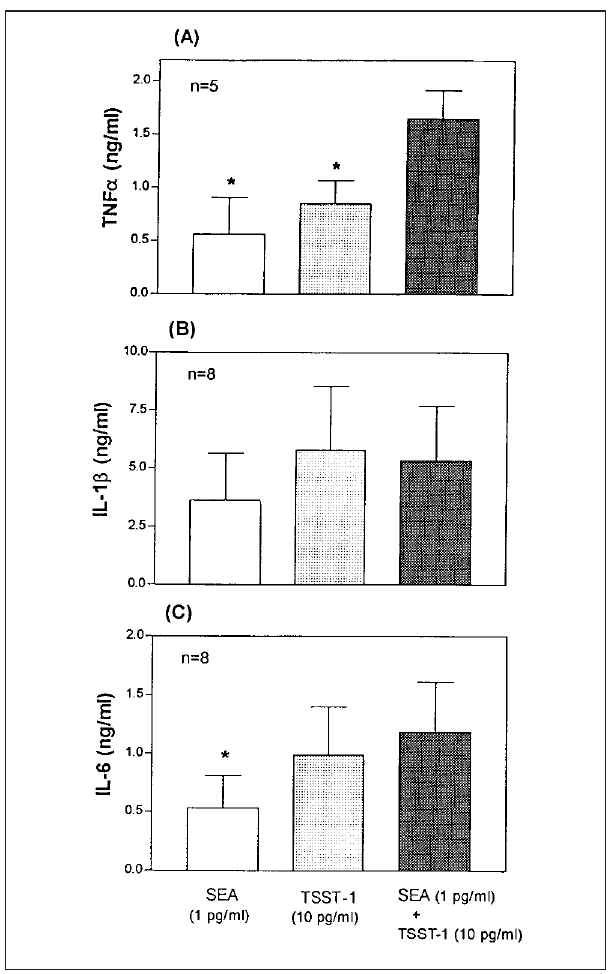
Figure 3) Induction of tumour necrosis factor-alpha (TNF (cid:2)(cid:3) , inter- leukin (IL)-1 in culture supernatant of human peripherial blood mono- nuclear cells from healthy donors after stimulation with toxic shock